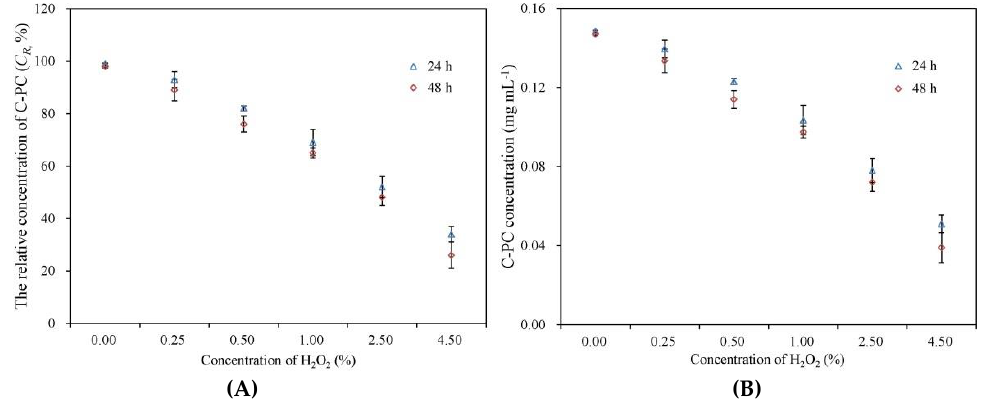
Figure 3. Degradation of C-PC exposed to different concentrations of H 2 O 2 after 24 and 48 h. ( A ) and ( B ) shows the results of relative concentration of C-PC and C-PC concentration, respectively.